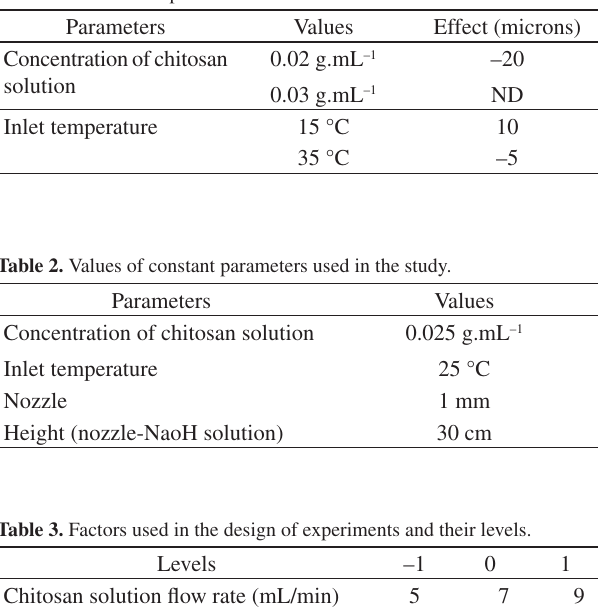
Table 1. Influence of parameters.